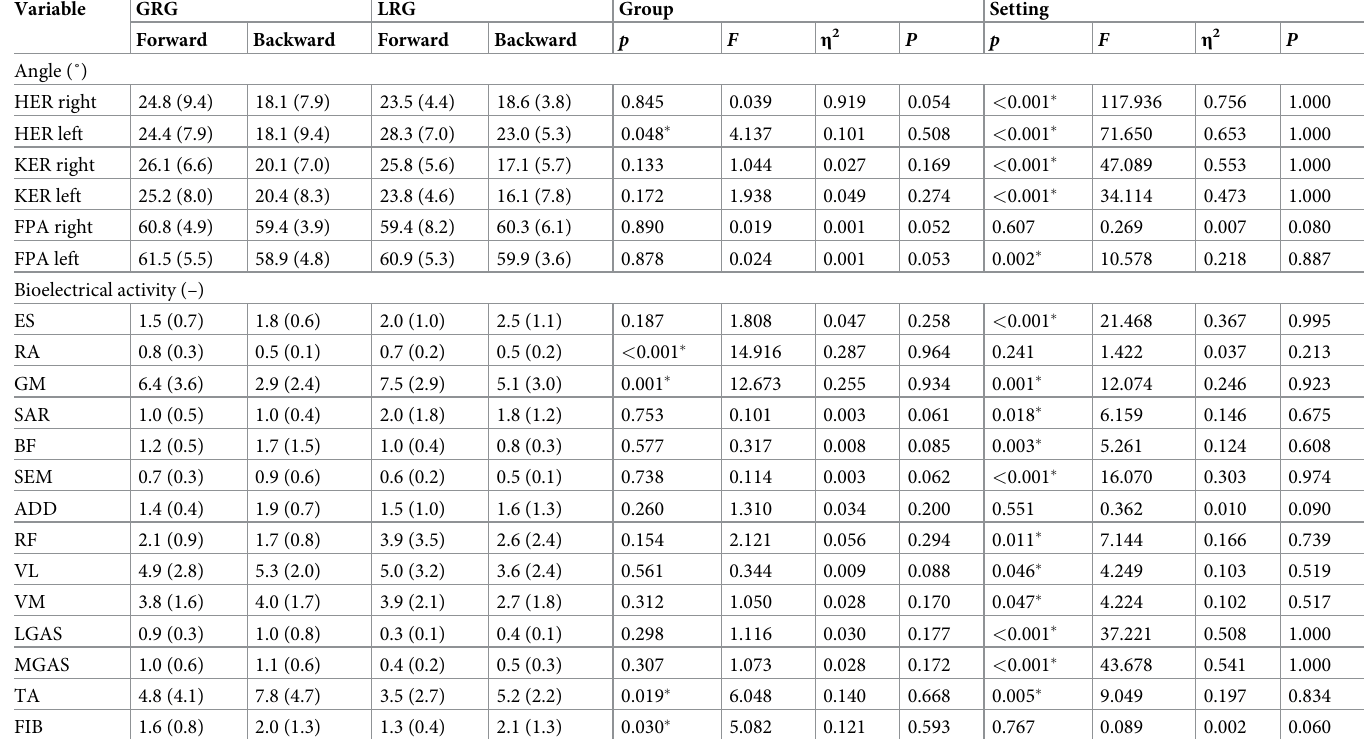
Table 3. Mean (SD) of the angles and bioelectrical activity in the third classical position (CP3), and p value, F statistic, effect size estimates and observed power of the repeated-measures ANOVA for group and setting factors.